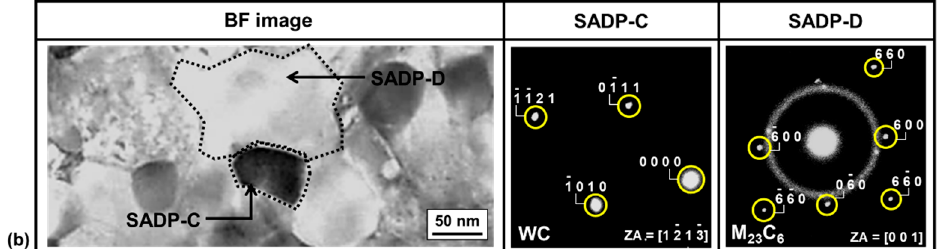
Figure 12. BF image and corresponding SADP for laser heat treated Stellite-1 coating at 1473 K: ( a ) Co and M 7 C 3 , ( b ) WC and M 23 C 6 .